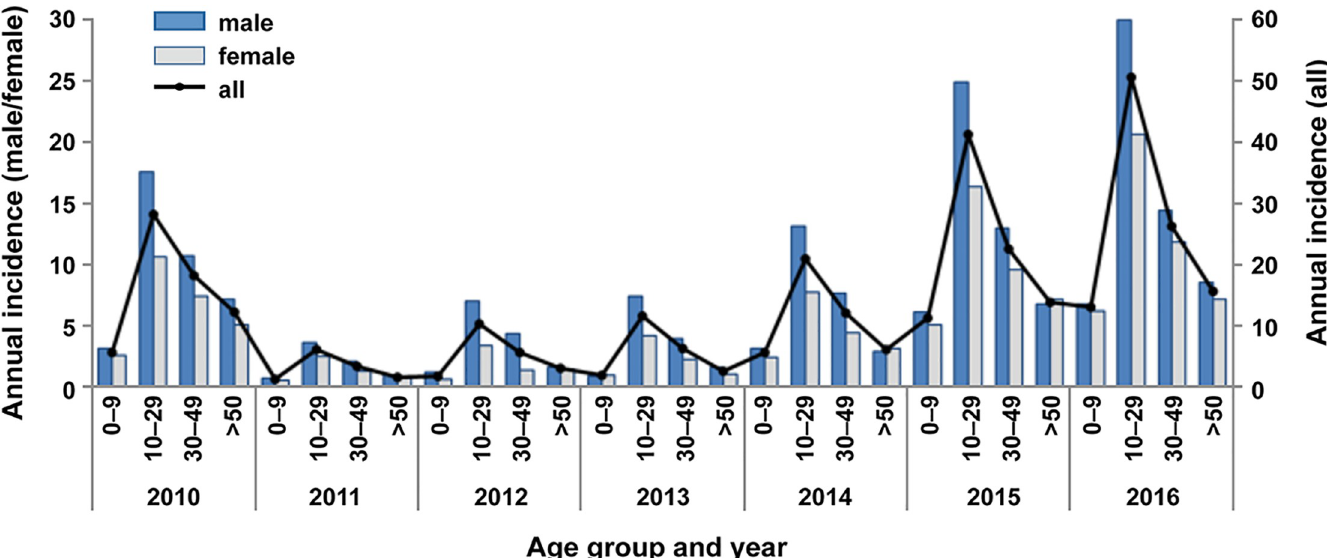
Fig 4. Incidence of dengue in Sabah by age group and gender, 2010–2016. Age- and gender-adjusted incidence rates (per 100,000 population) across Sabah during the 7-year period are shown for males, females and for both